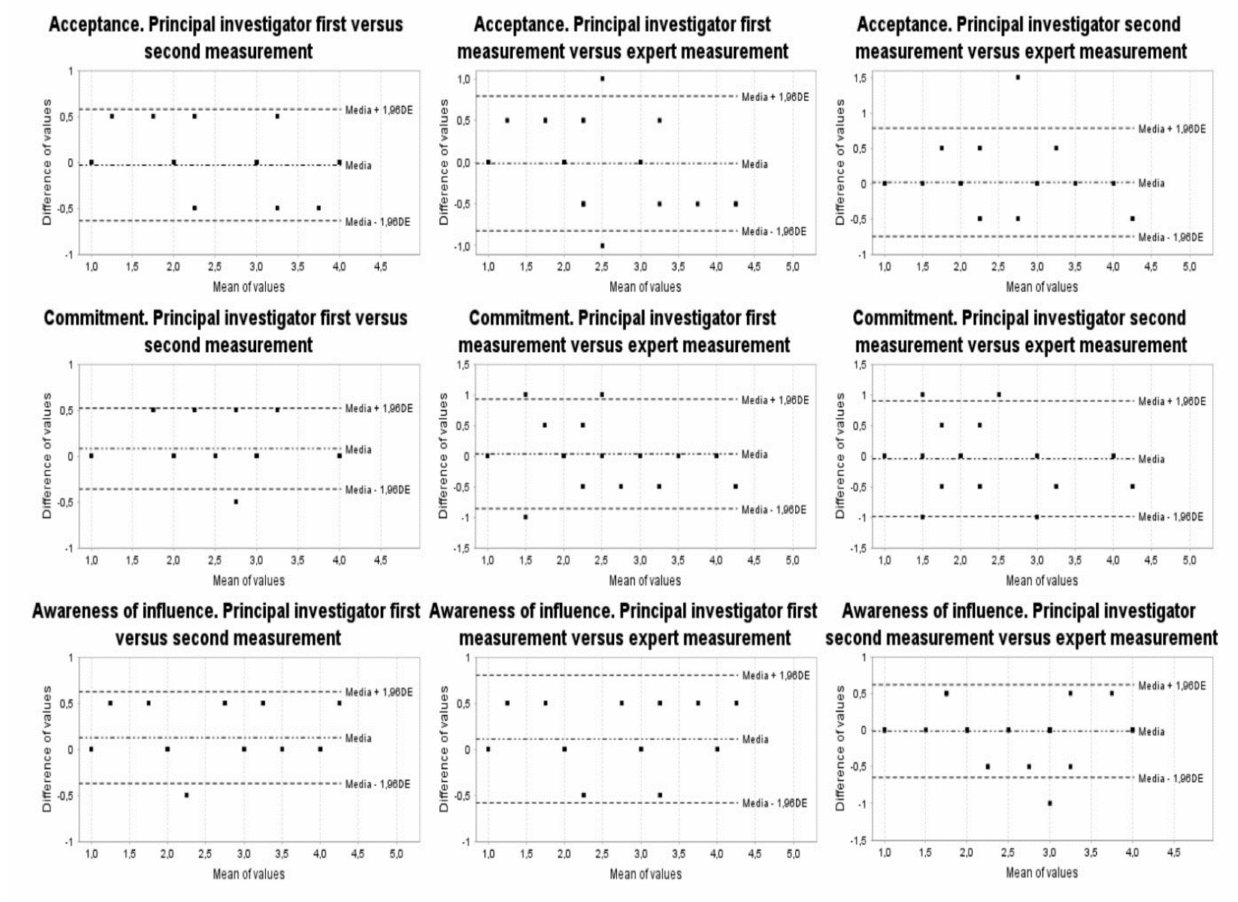
Figure 1. Inter-rater reliability (Bland–Altman plots).